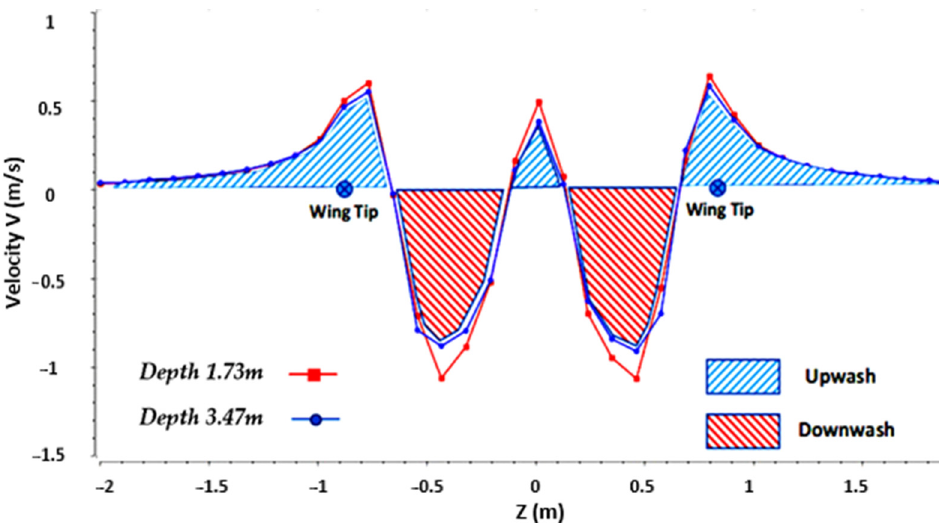
Figure 9. Vertical velocity profile plotted along an axis passing through the core of the vortex flow for different depth (3.47 m and 1.73 m).